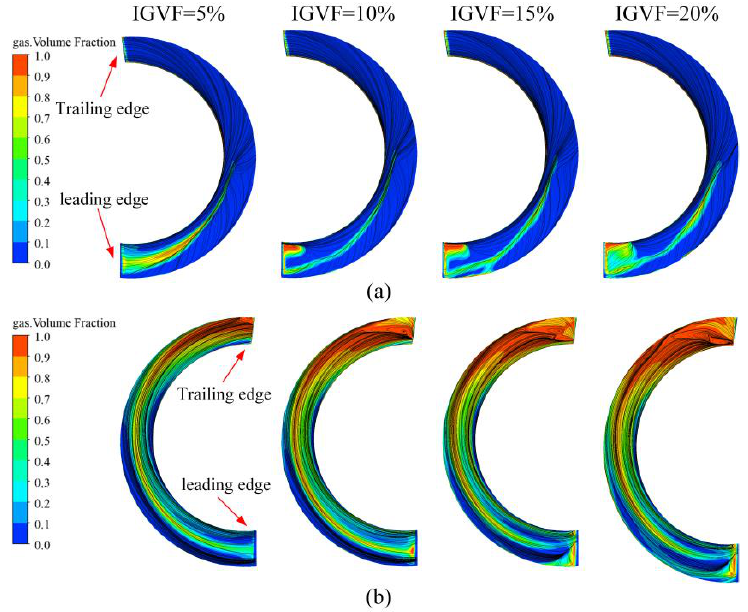
Figure 14. Gas volume fraction on the blade surface. ( a ) Pressure surface and ( b ) suction surface.